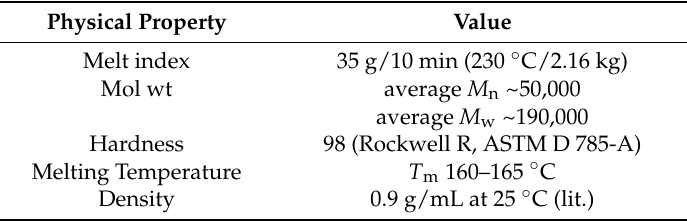
Table 1. Main physical properties of unfilled